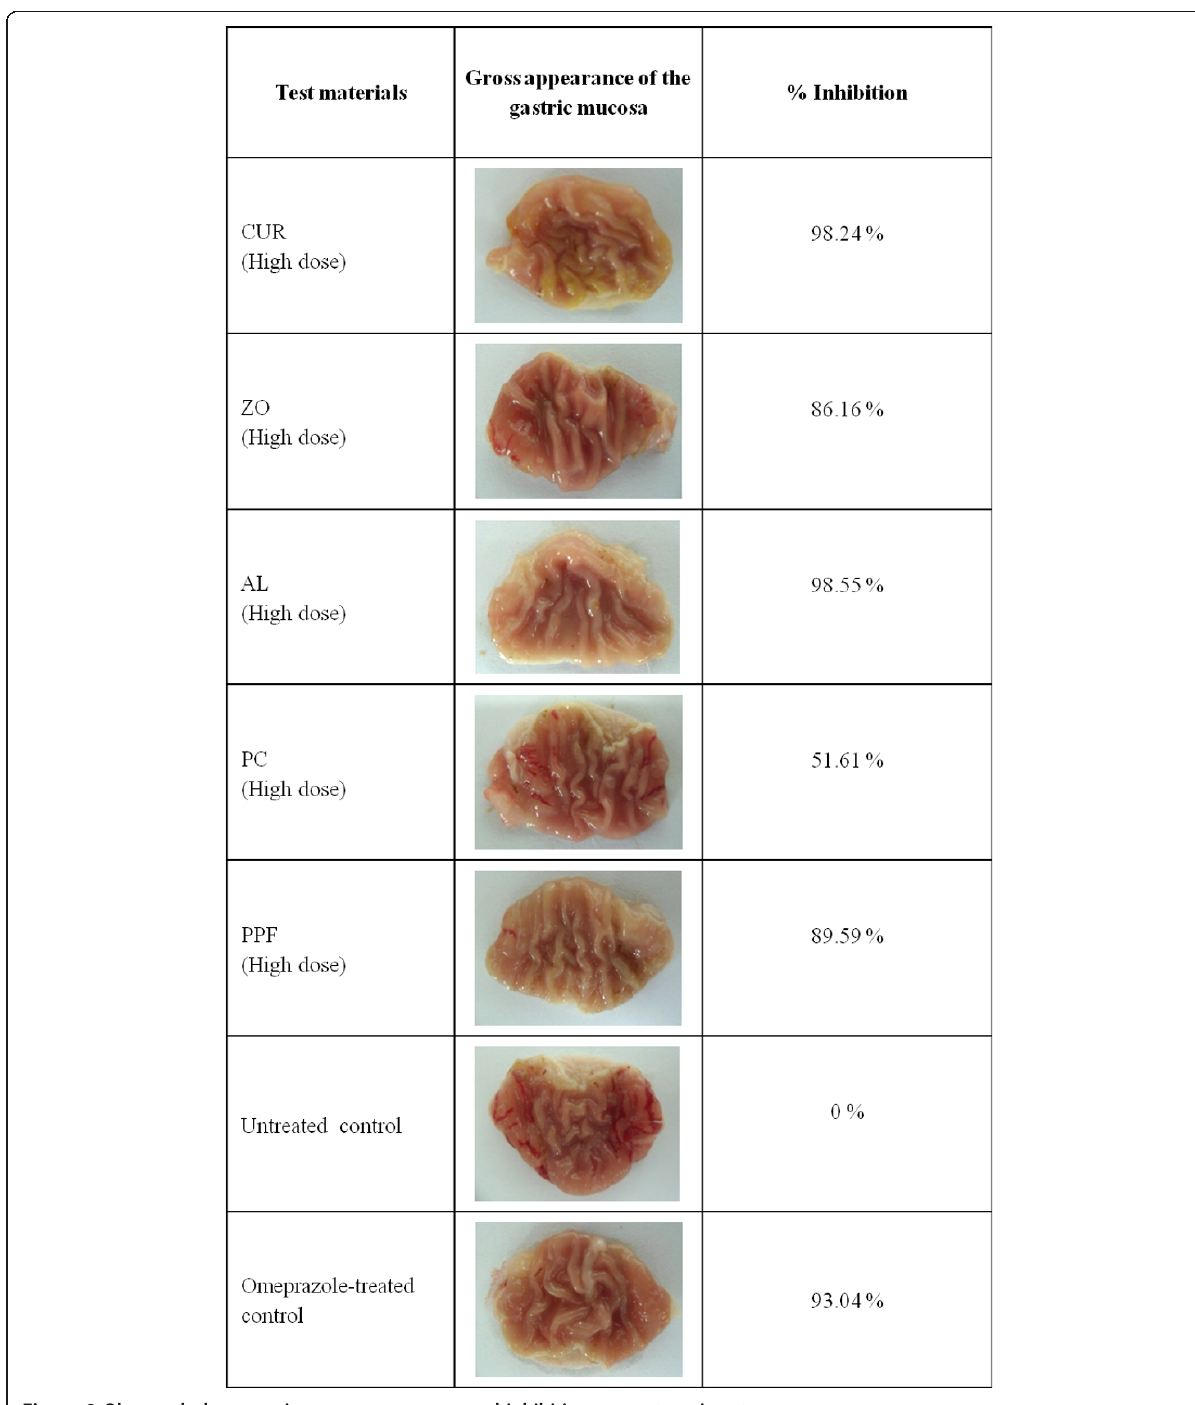
Figure 9 Observed ulcer area in gross appearance and inhibition percentage in rats longitudinal and transverse diameters) using calipers with accuracy of 0.1 mm. The tumor volume was cal- culated from the formula: tumor volume = (length) (width) 2 /2.